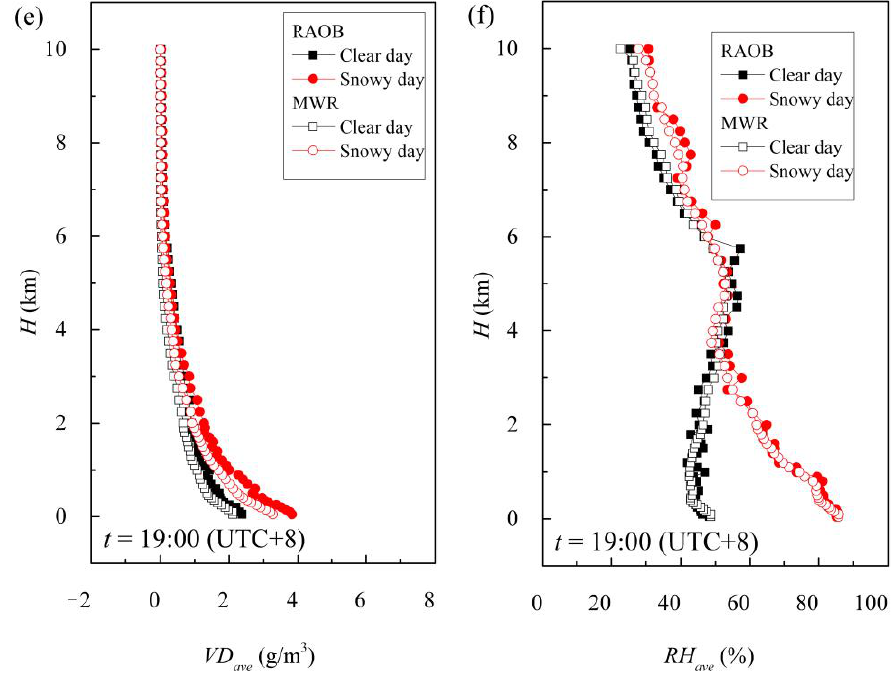
Figure 4. Comparison of temperature ( a , d ), vapour density ( b , e ), and relative humidity ( c , f ) profiles obtained from MWR and RAOB under clear-sky and snowy-sky conditions.